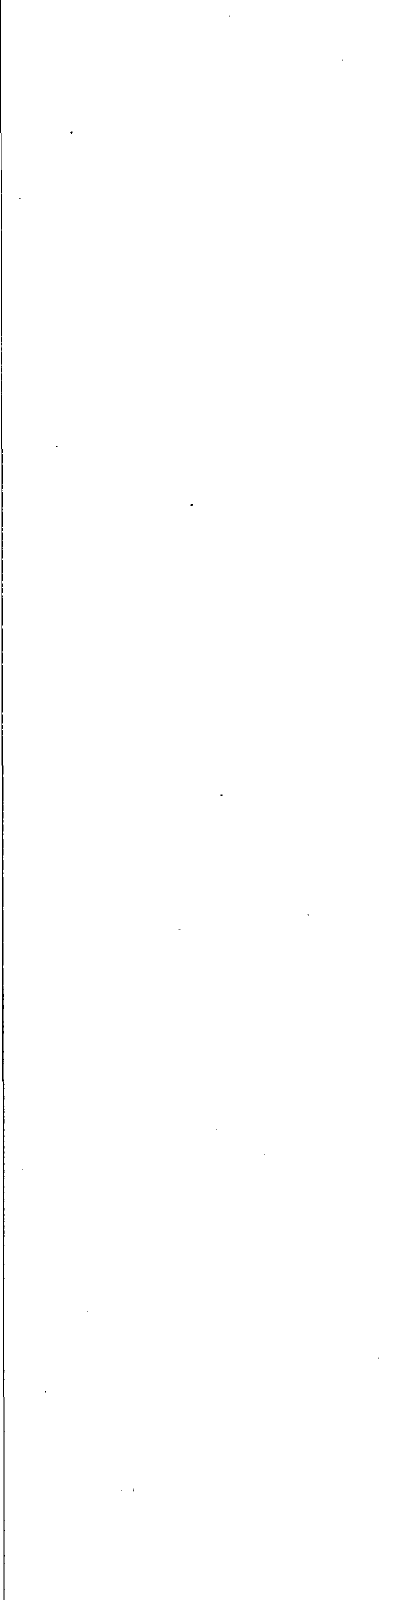
Table I: Analysis of returned evaluation disks (N = 25) Attitude scale and